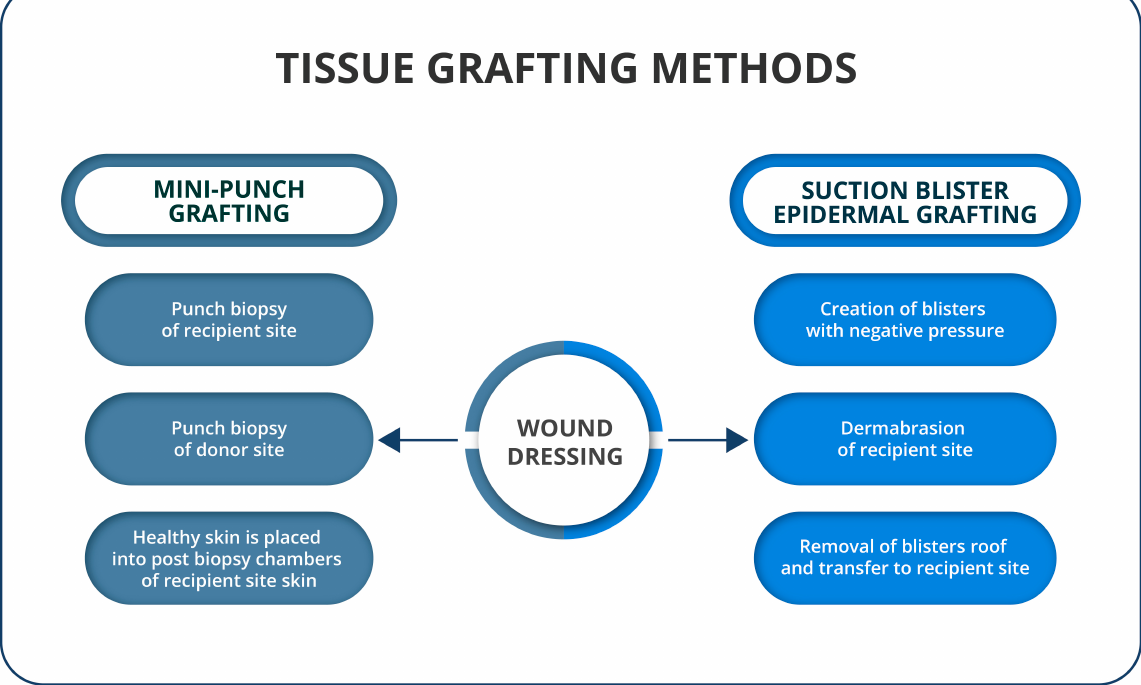
Figure 2. Course of tissue grafting